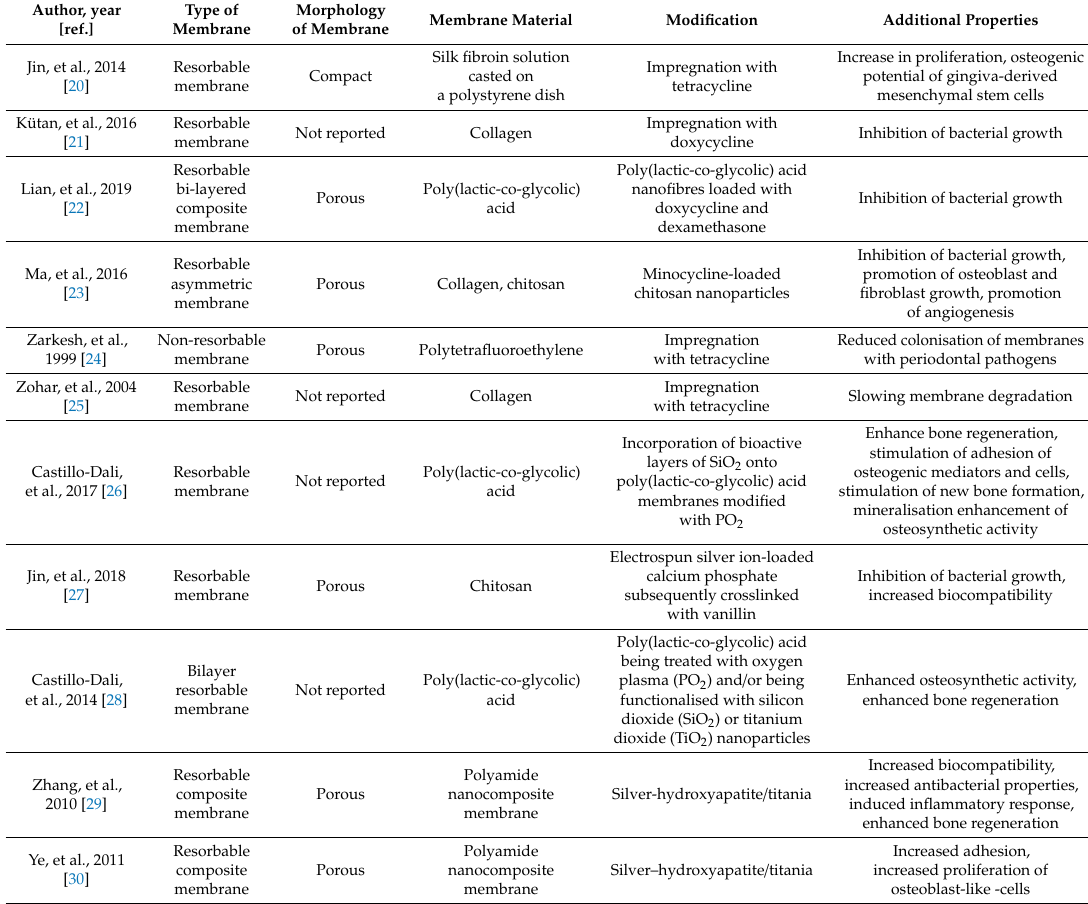
Table 1. Summary of included